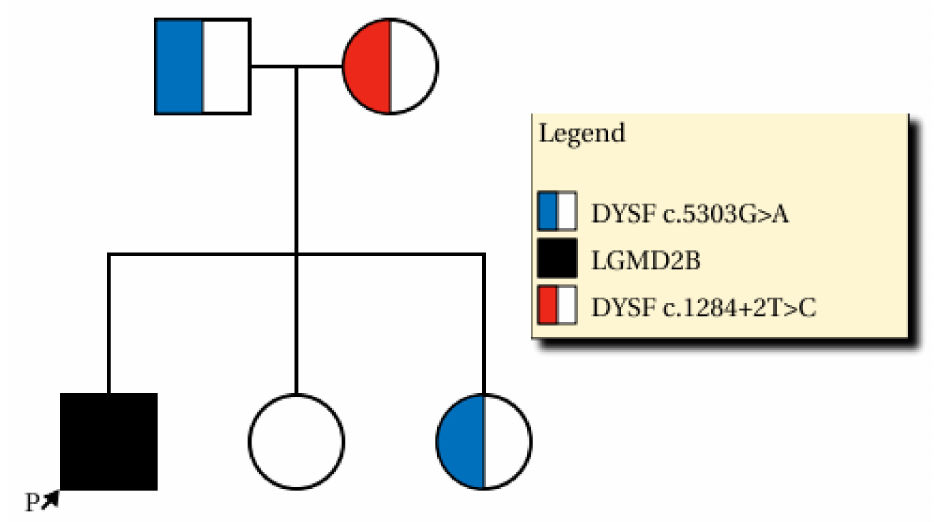
Figure 3. Family pedigree diagnosed with compound heterozygous DYSF (dysferlin gene) variants. The black filled-in pedigree member is the patient (NM_003493.3:c.5303G > A and NM_003493.3:c.1284 + 2T > C), the blue half-filled pedigree member indicates the heterozygous carrier with a pathogenic variant (c.5303G > A), whereas the red half-filled pedigree member is the heterozygous carrier with a previously reported pathogenic variant (c.1284 + 2T >